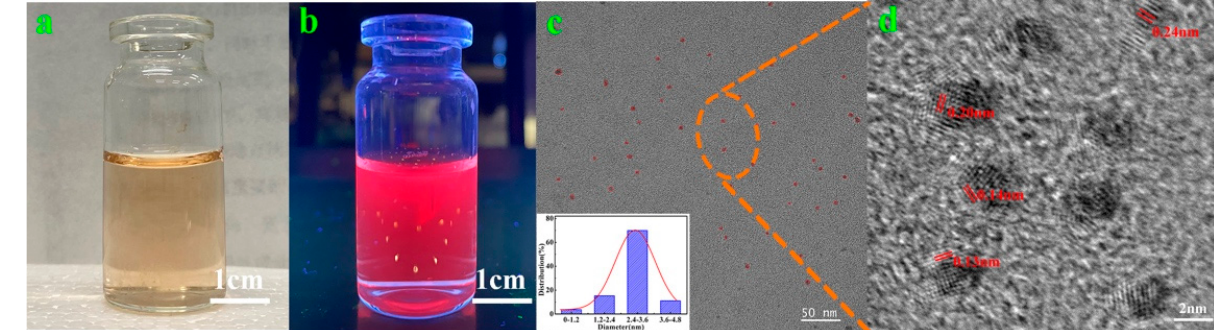
Figure 1. AuNCs: ( a , b ) appearance morphology of AuNC solution under visible light and UV lamp; ( c , d ) AuNC TEM (inset: AuNC diameter distribution) and HR-TEM image.